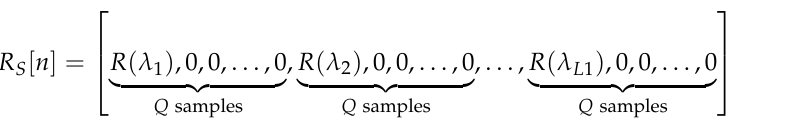
Figure 11. Sketch of the mutual correlation → polynomial fit based peak tracking with wavelength shifting. The autocorrelation is estimated for the same FBG as in Figure 9.